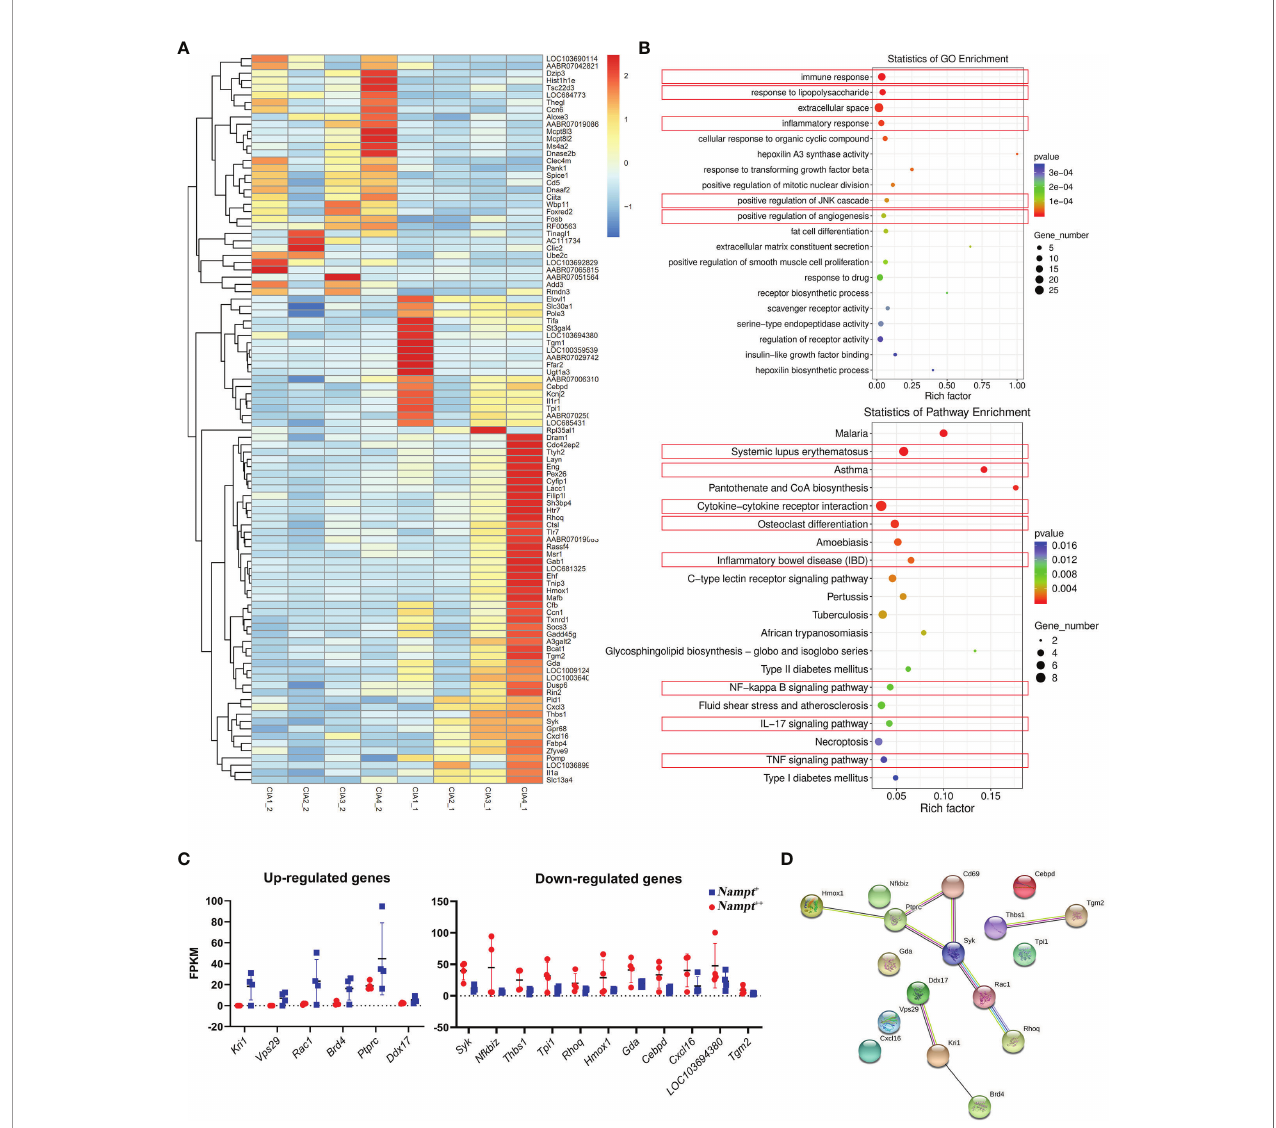
FIGURE 3 | Screening of genes differentiating transcriptional pro fi les of CIA rats at different Nampt expression statues. (A) differentially expressed genes between Nampt ++ and Nampt + samples collected from identical rats revealed by RNA-sequencing; (B) results of pathway enrichment analyses using differentially expressed genes based on either GO or KEGG annotation, and those closely related to in fl ammation were highlighted in red; (C) manually selected genes with reliable changes; (D) interactions among selected differentially expressed